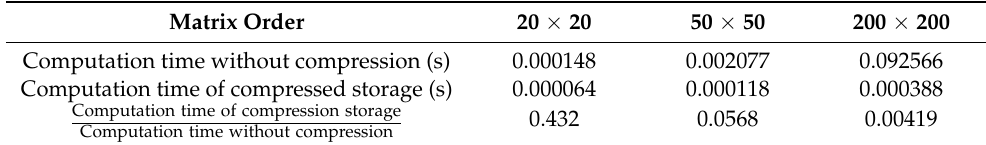
Table 2. Comparison of the computation time.